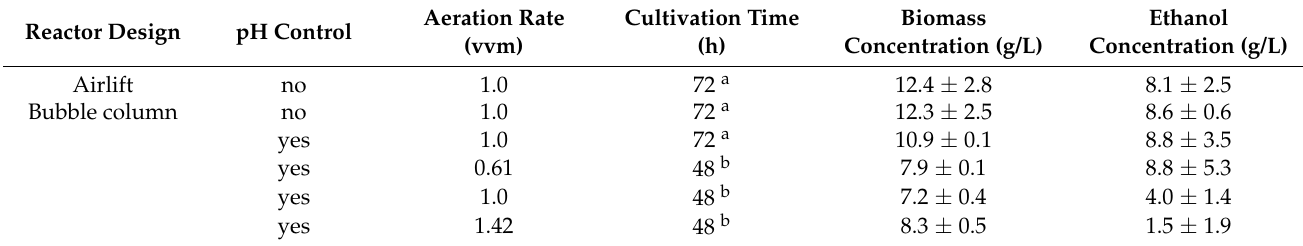
Table 3. Biomass and ethanol concentrations for the fed-batch cultivations in 4.5 L reactors. The values presented are the final concentrations of the biomass and ethanol at 72 or 48 h. Reactor Design Airlift Bubble